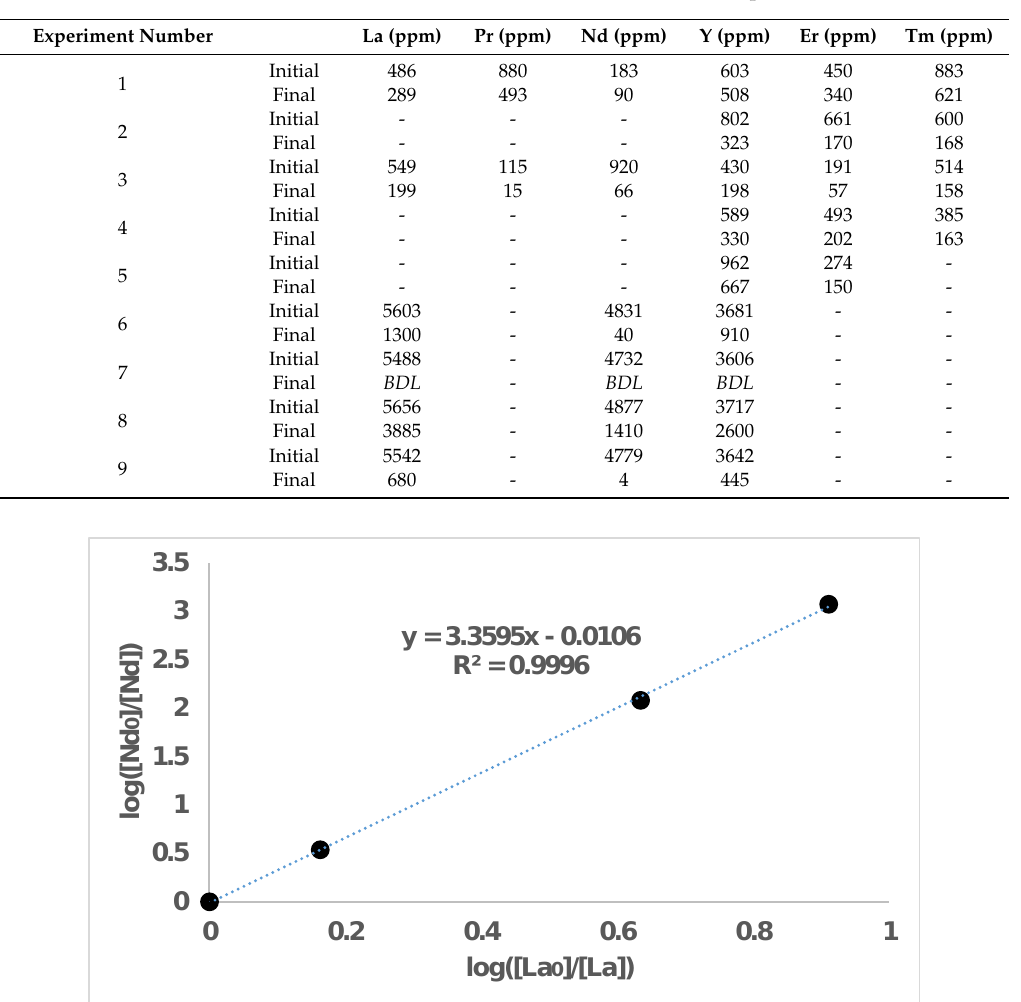
Table 2. Initial and final solution concentrations for each experiment.